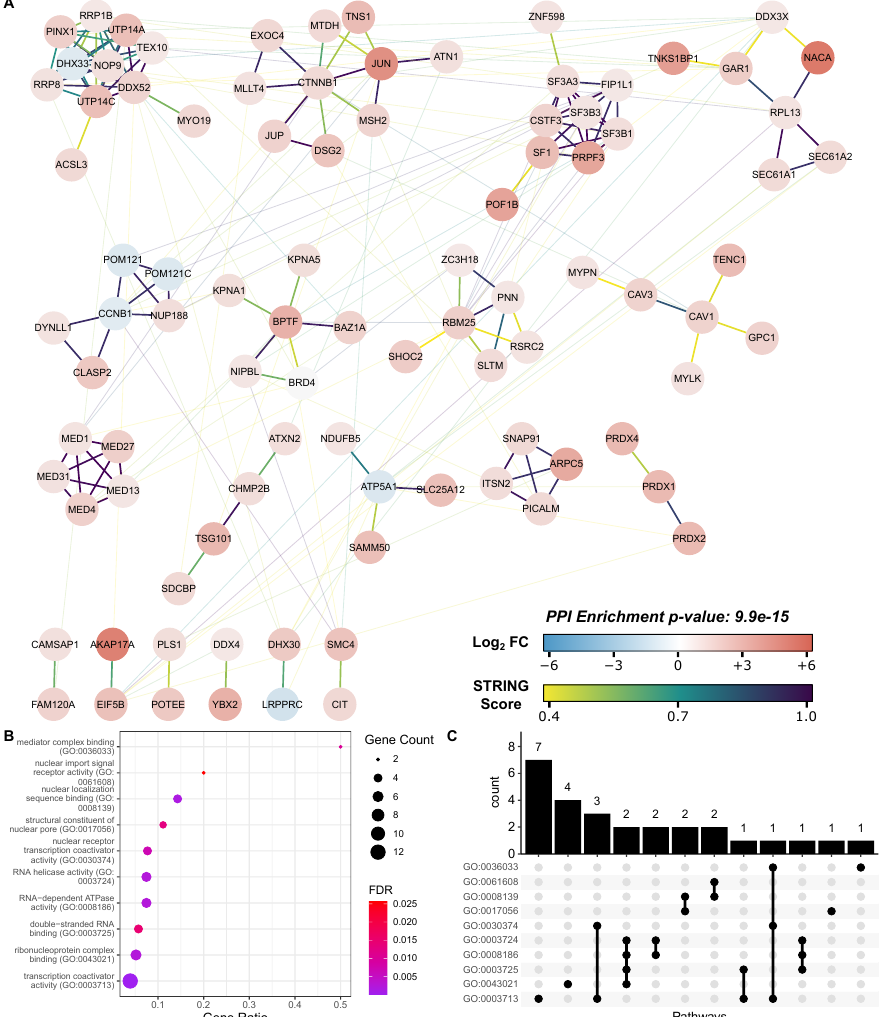
Figure 7. STRING analysis of RSV-inducible and bromodomain-sensitive BRD4 interactors. ( A ) Cytoscape network visualization of 101 RSV-inducible and bromodomain-dependent BRD4 interactors. Node color represents the RSV-inducible Log fold change. Edge color is keyed to the STRING score and represents interaction confidence. Low confidence 2 interactions (STRING score < 0.4) and nodes without interactions are omitted. ( B ) STRING Molecular Function GO Analysis. Dot size represents the number of identified proteins within a GO group. Gene ratio indicates the fraction of all proteins within the GO group that were identified. Color represents the FDR-adjusted p -value of the GO over-representation test. ( C ) UpSet plot of proteins with shared GO terms. Each bar represents the number of proteins shared between marked